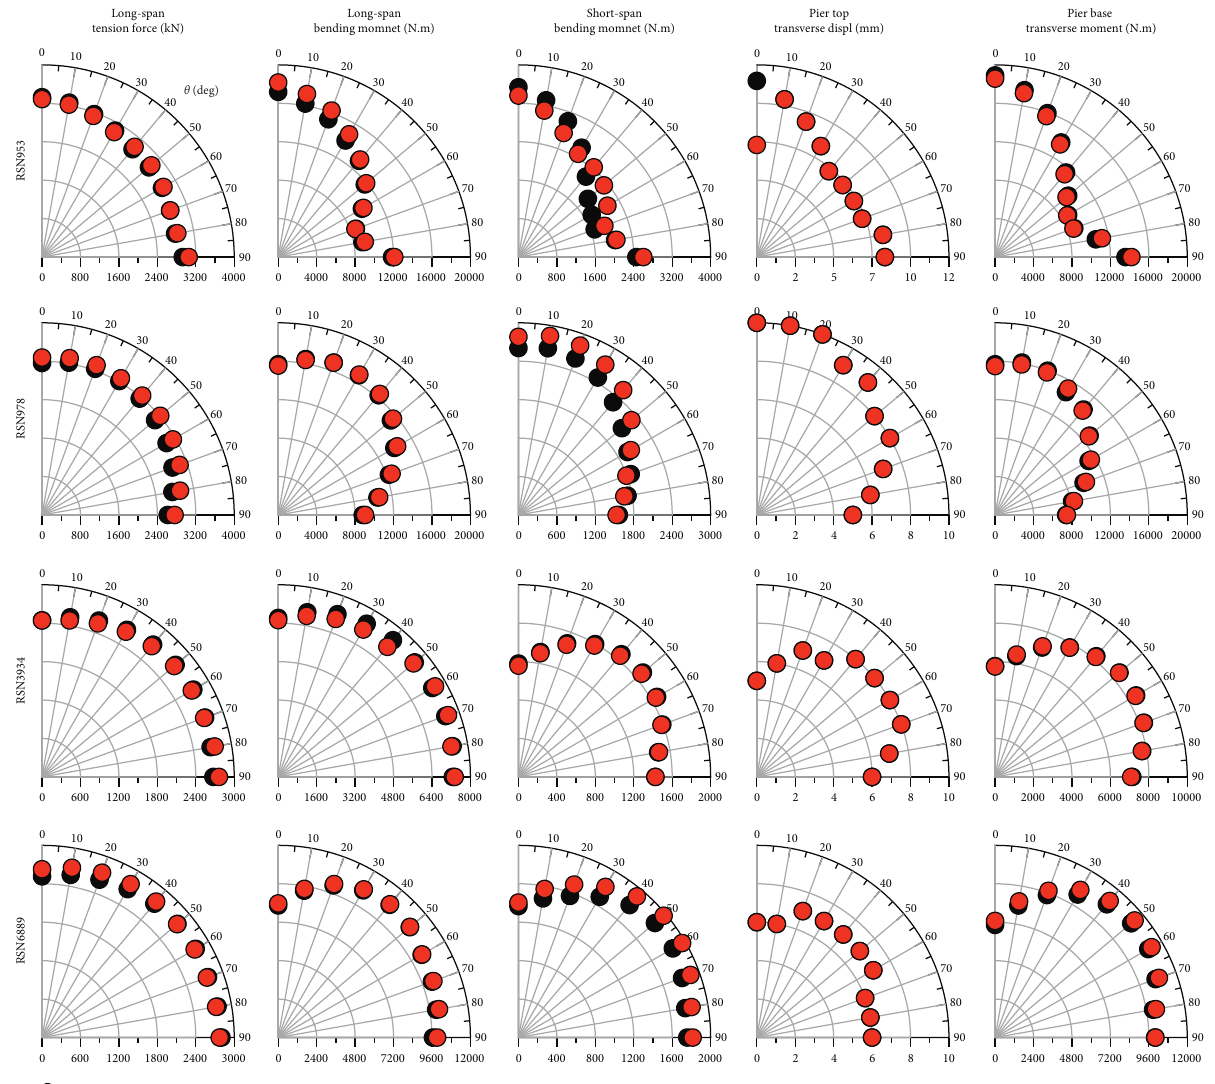
Figure 9: Distribution of responses obtained from non-pulse-type ground